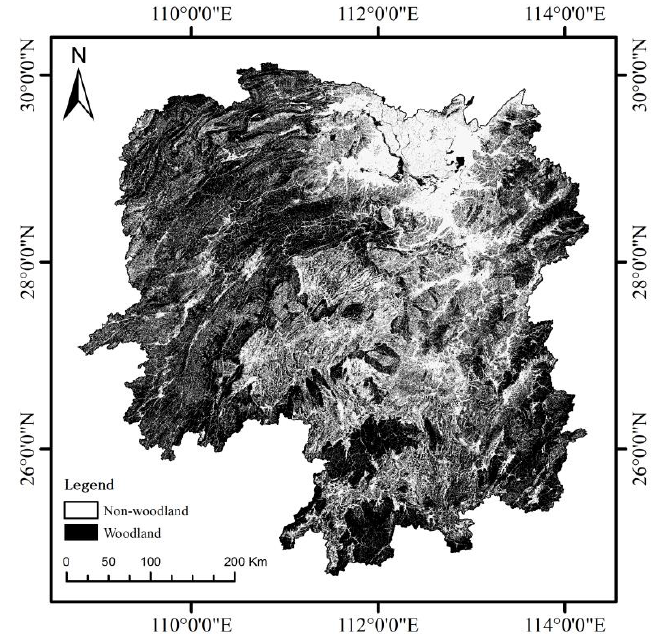
Figure 2. Woodland Resources Map in Hunan Province.